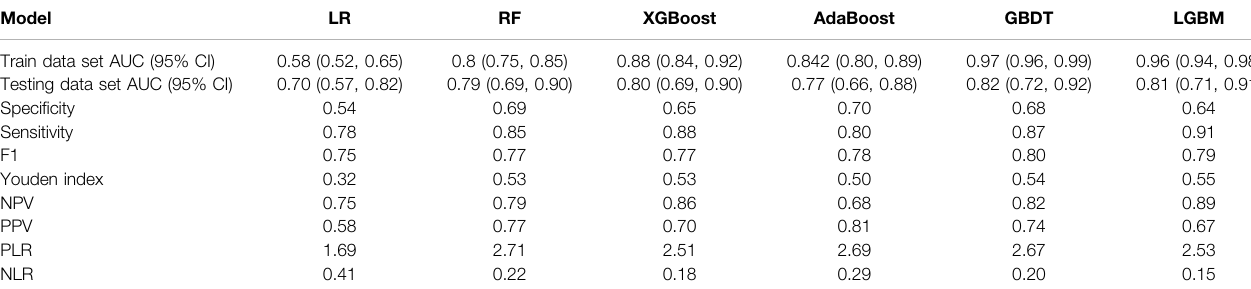
TABLE 3 | Summary of prediction results of six ML algorithms based on the training data set and testing data set.